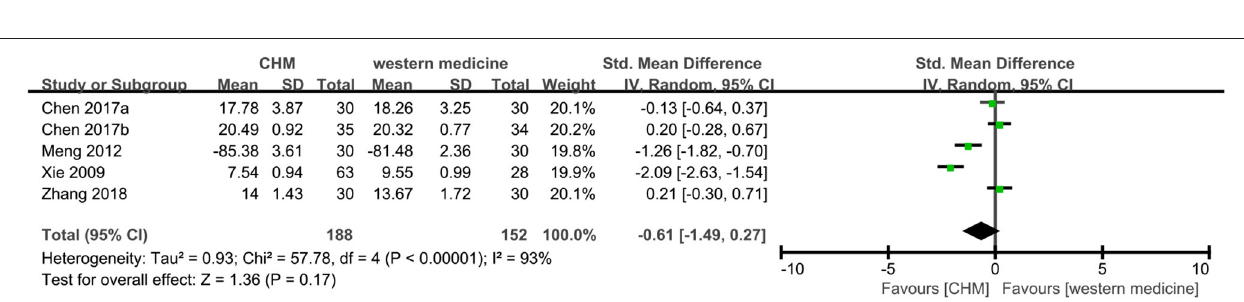
Frontiers in Neurology | www.frontiersin.org 12 June 2022 | Volume 13 | Article